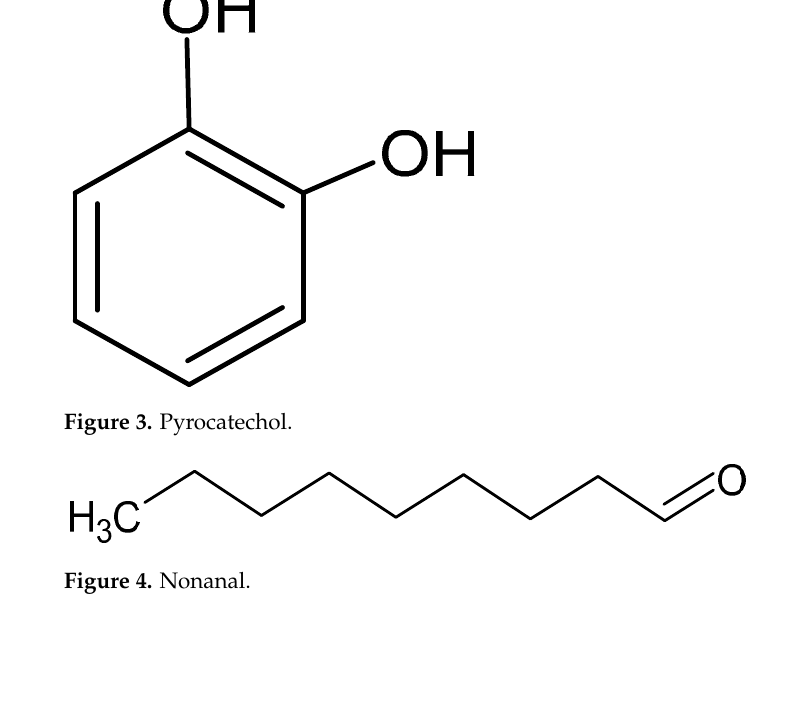
Figure 2. Chromatogram from the 11th and 12th fractions from the chloroformic extract of aerial parts of Salvia connivens. The “X axis is the area under the curve; the “Y” axis is retention time.